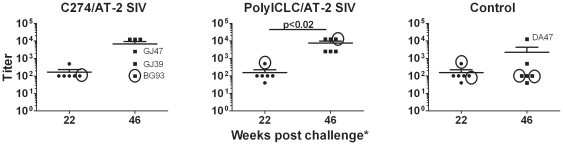
PolyICLC/AT-2 SIV vaccination increases neutralizing Ab activity.Neutralizing Ab titers in the plasma were determined before and after vaccination (vaccination on weeks 26, 32, 38, and 44 post infection). Levels were measured in samples taken 22 weeks after infection and 46 weeks post infection for all animals except CK25 (week 42) and EL02 and GJ65 (week 49) (asterisk). The titer (the last dilution tested at which infection was blocked) is shown for each animal and the mean for each group is marked by the horizontal bar. The circled symbols denote the animals that were ART partial or non-responders. Animal ID numbers are indicated for animals with outlier values relative to the rest of their respective groups.